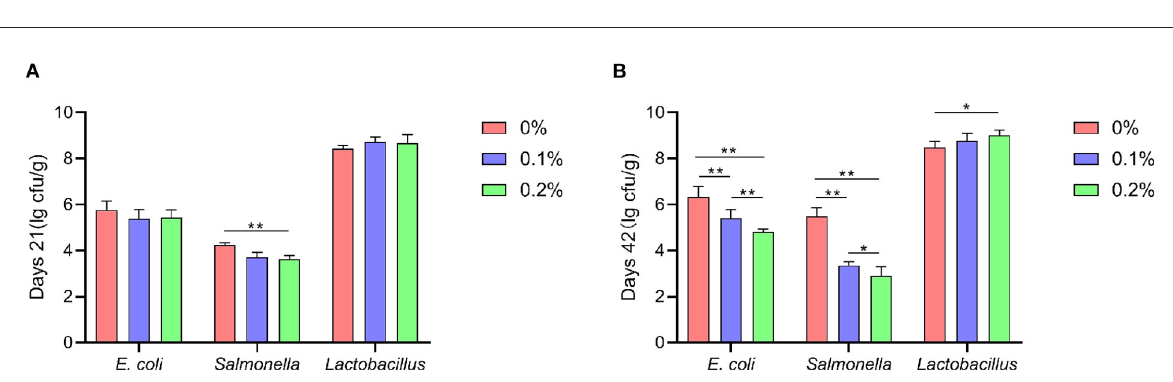
Slaughter rate, breast muscle rate and leg muscle rate were crucial indicators of meat production performance in broilers and provided a useful assessment of carcass traits. The relative